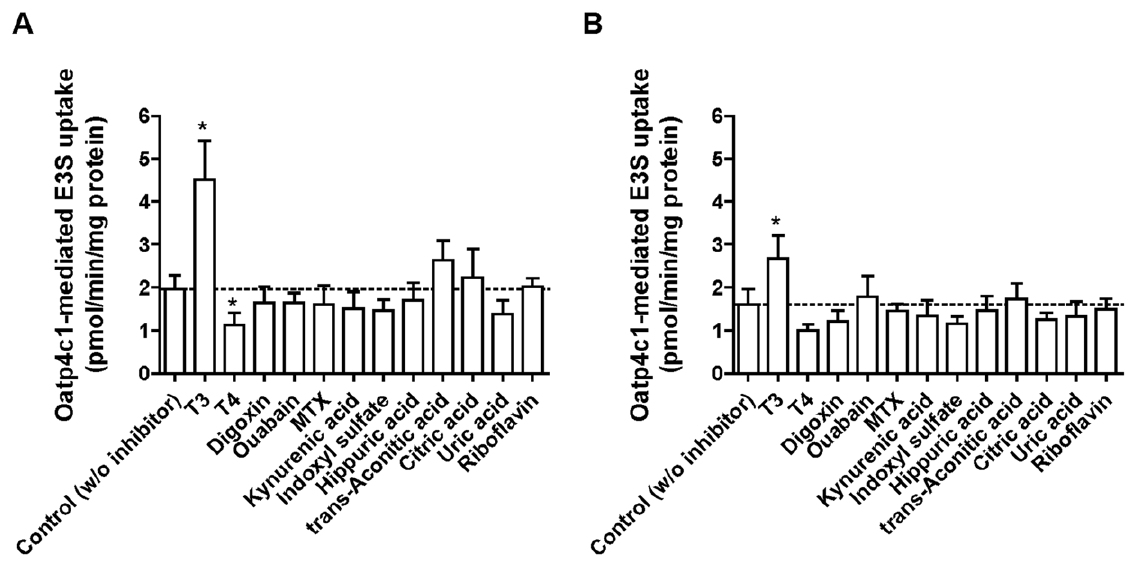
Figure 8. The effect of uremic toxins and anionic physiological substances on Oatp4c1-mediated E3S transport. Inhibition of Oatp4c1- mediated [ 3 H]-E3S uptake (1 min) was determined in the absence (control) and presence of various compounds (100 m M) at pH 5.5 (A) and 7.4 (B). Oatp4c1-mediated uptake was estimated after subtracting the nonspecific uptake measured in pcDNA cells treated under identical conditions. In all studies the [ 3 H]-E3S concentration was 0.5 m M. GF: GF120918, MTX: methotrexate. Each point represents the mean 6 S.D. of triplicates. *p , 0.05, significant differences from control.